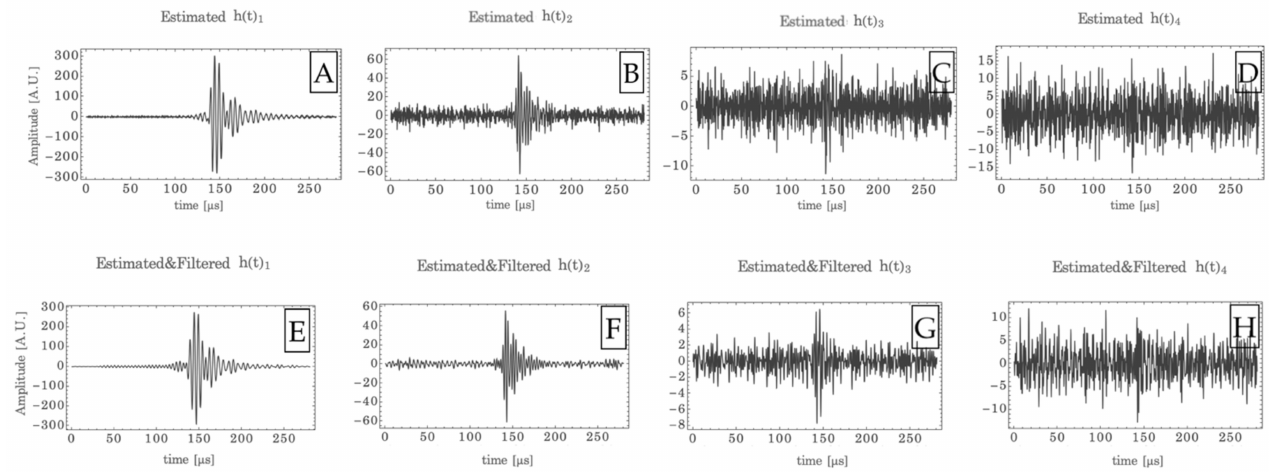
Figure 9. Estimated h k ( t ) kernels in the case of the ultrasonic acquisition system designed for in-air propagation in the case of the lower SNR value (20 [dB]). Plots ( A – D ): h 1 ( t ) , h 2 ( t ) , h 3 ( t ) , h 4 ( t ) estimates before lowpass filtering. Plots ( E – H ): h 1 ( t ) , h 2 ( t ) , h 3 ( t ) , h 4 ( t ) estimates after lowpass